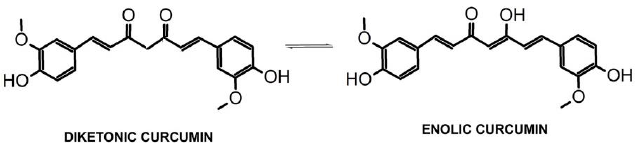
Figure 1. Keto-enolic tautomerization of curcumin.